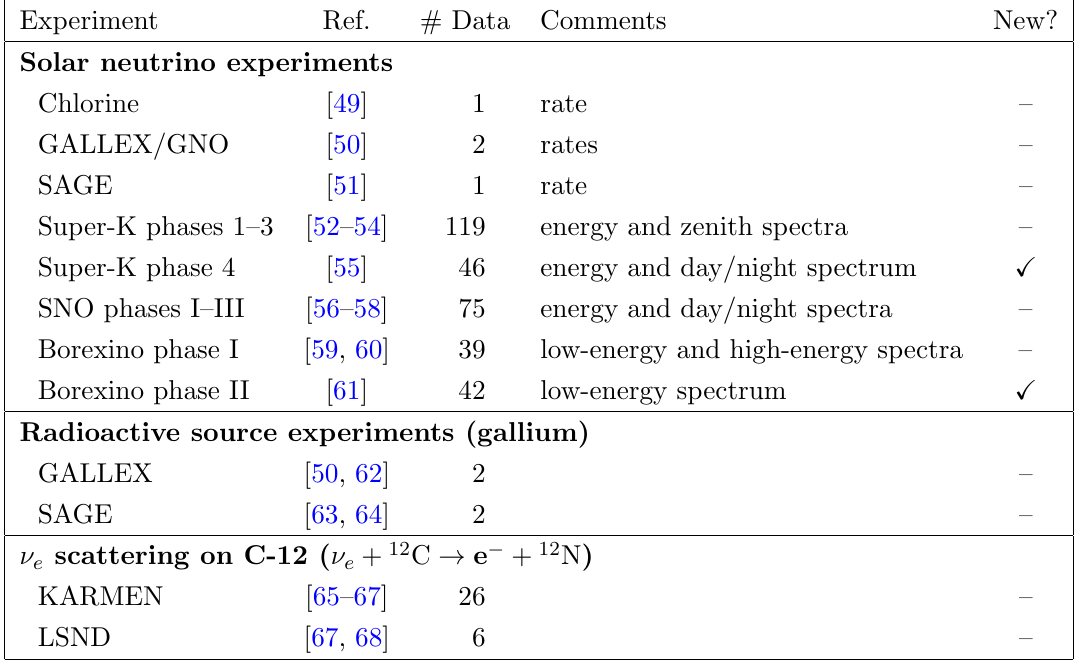
Table 5 . Experimental data which we combine with the reactor data from table 2 in our global (cid:23) e /(cid:22) (cid:23) e disappearance analysis. In the last column we indicate updates with respect to ref. [16]. The total number of data points of non-reactor data is